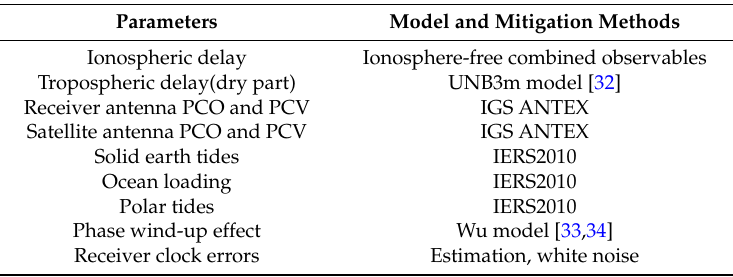
Models used in multi-constellation kinematic precise point positioning (PPP) data preprocessing. PCO: phase centre offsets; PCV: phase centre